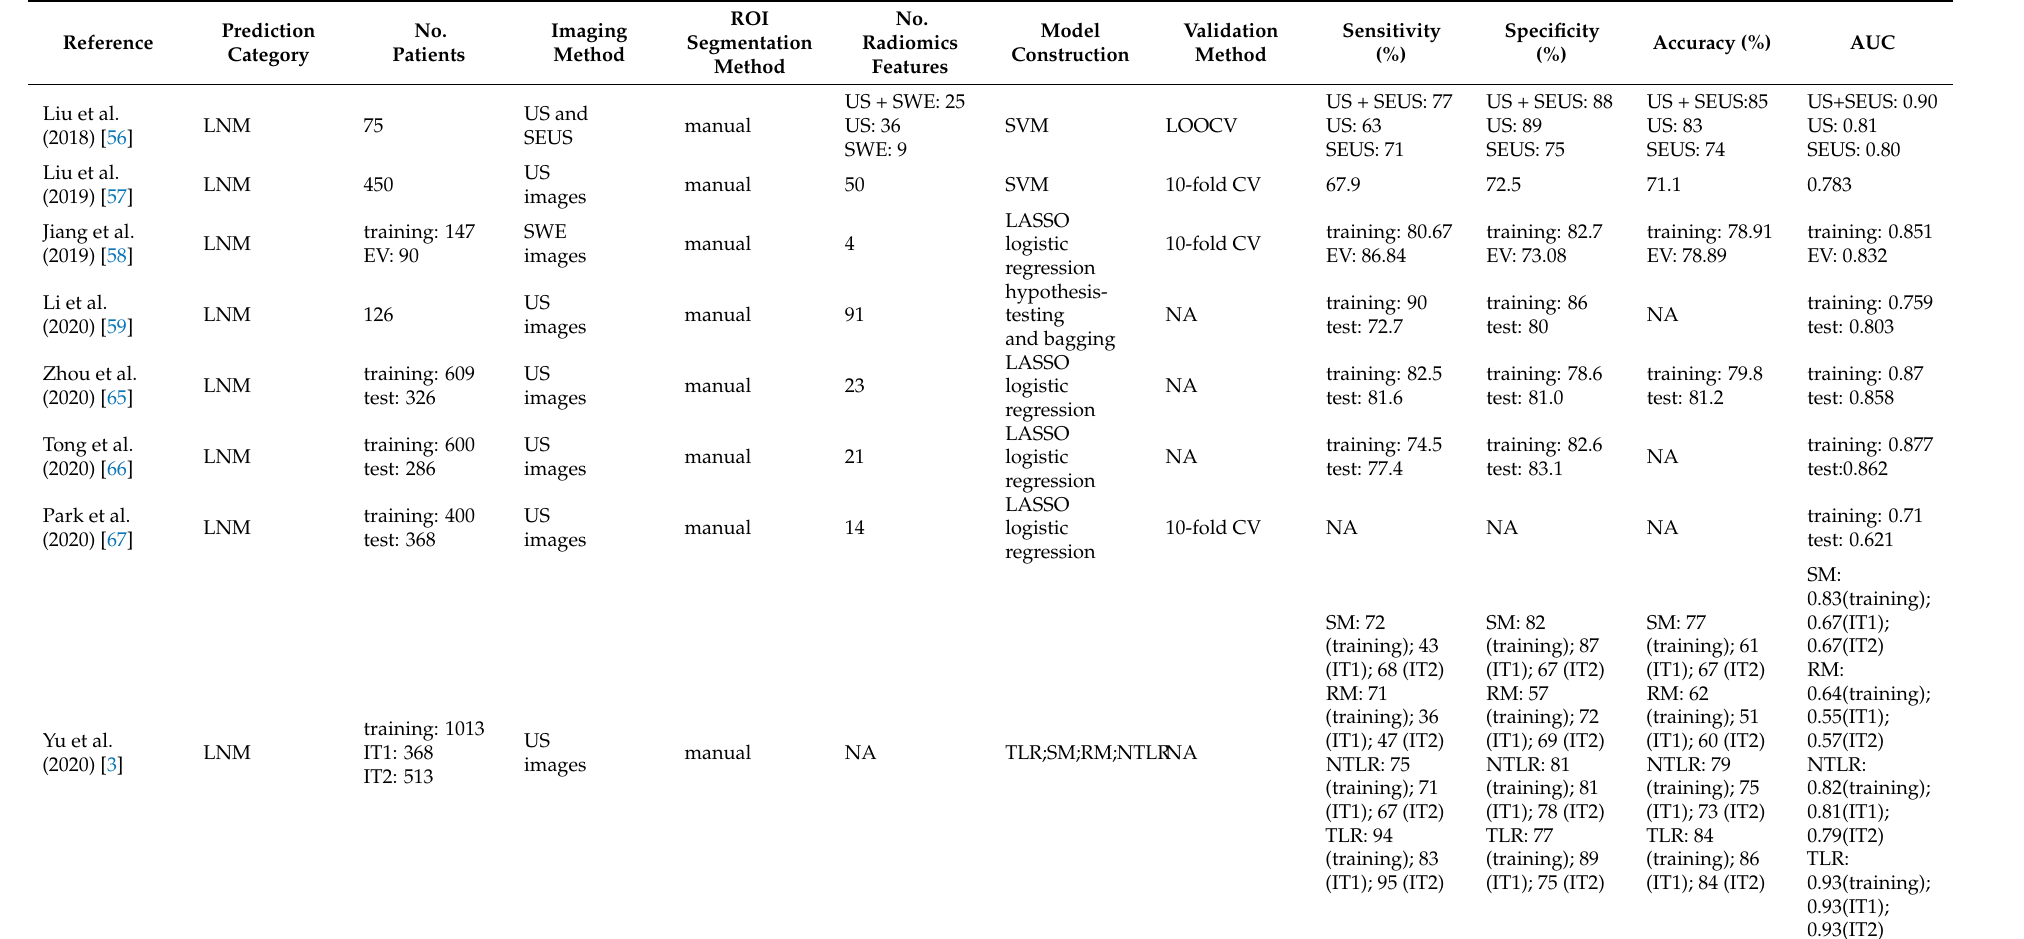
Table 1. Studies used radiomics for the prediction of metastasis, tumor progression, treatment response, and gene